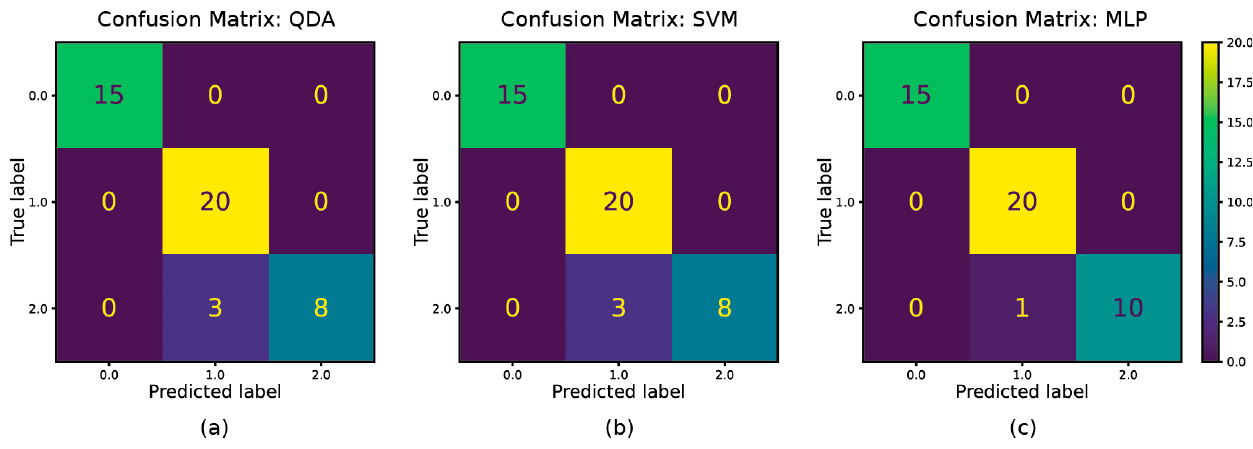
Figure 11. Confusion matrices for ( a ). QDA (with PCA), ( b ). SVM, and ( c ). MLP classifiers. Table 5. Test data classification report summary for QDA (with PCA), SVM, and MLP classifiers.